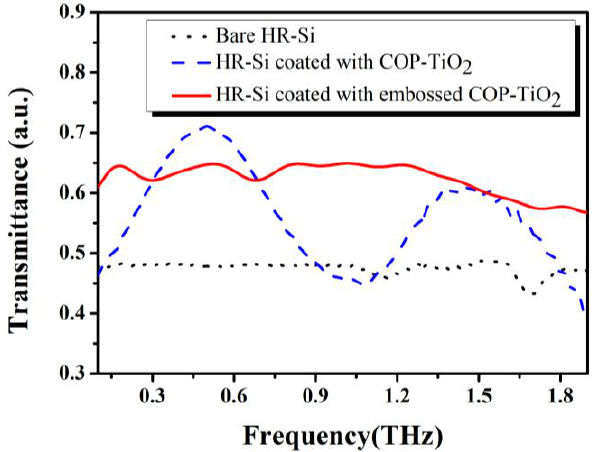
Figure 4. Transmission spectra of the bare high-resistance silicon (HR-Si) substrate (black dotted line), an HR-Si substrate coated with a flat COP–TiO 2 layer (blue dashed line), and an embossed COP–TiO 2 layer (red solid line).